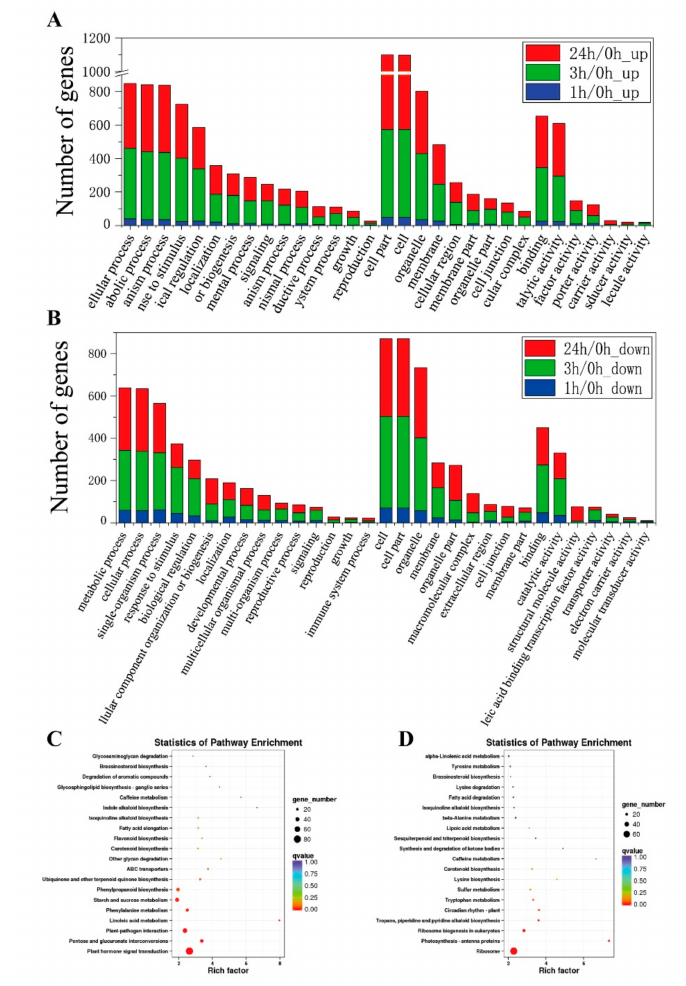
Figure 5. The functional annotation of di ff erentially expressed genes (DEGs) in Brassica napus leaves under the freezing treatment. ( A , B ) are GO annotation, ( A ) up-regulated DEGs, ( B ) down-regulated DEGs. ( C , D ) are KEGG pathway enrichment, ( C ) up-regulated DEGs, ( D ) down-regulated